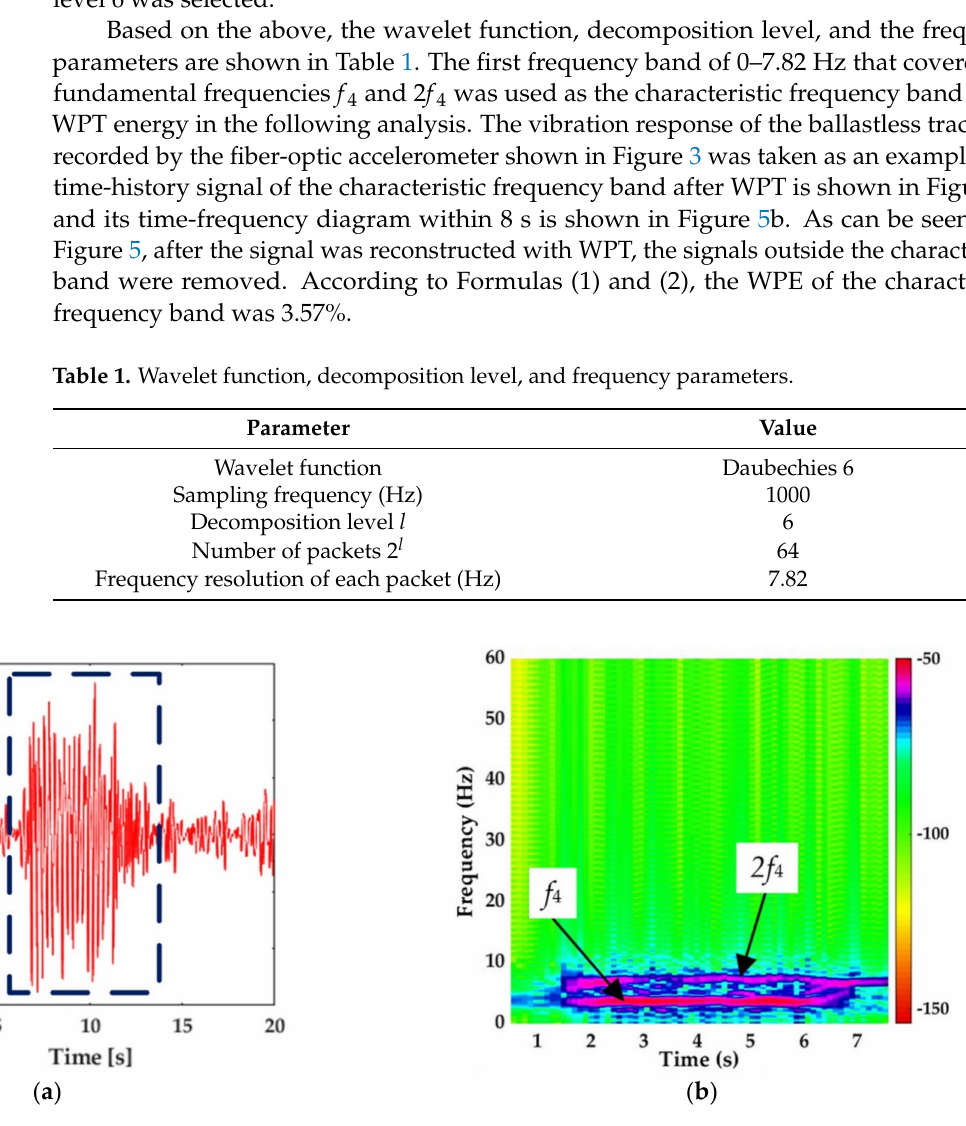
Figure 5. Reconstruction of vibration signal of characteristic frequency bands by the wavelet packet. ( a ) The time-history signal. ( b ) The time-frequency